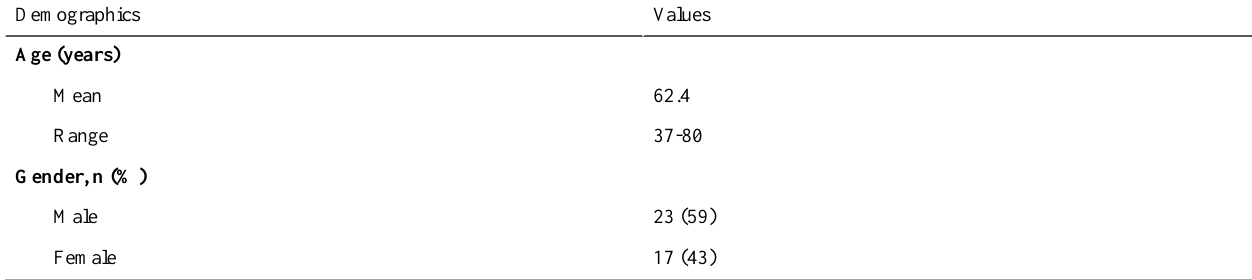
Table 1. Participant demographics